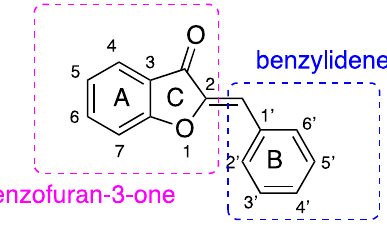
Figure 2. General structure of aurones.